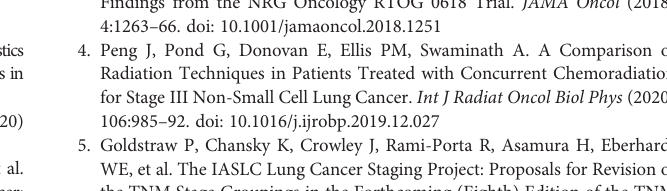
Supplementary Figure 1 | Chemical structure of LC-C. Supplementary Figure 2 | The overall survival rates of lung cancer patients with high ERRFI1 level and low ERRFI1 level were evaluated with Kaplan – Meier Plotter. The high expression level of ERRFI1 was associated with high overall survival